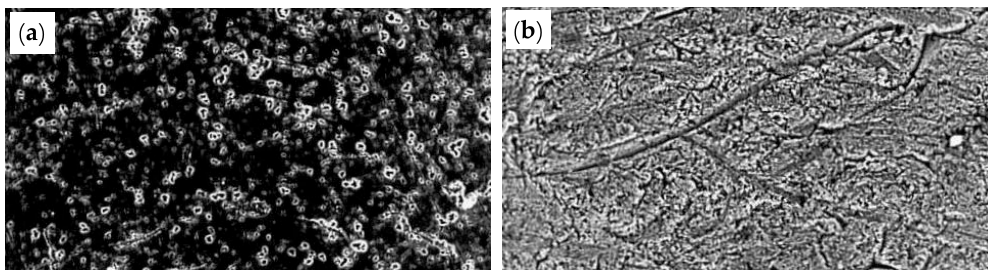
Figure 35. Die surface according to the size of the abrasive grains (as observed by SEM): ( a ) abrasive size 2–4 μ m; ( b ) abrasive size 8–10 μ m. Reprinted with permission from ref. [88].